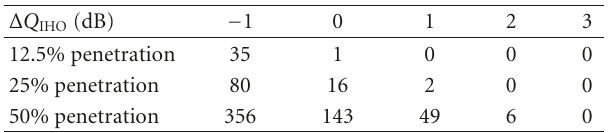
Table 5: Outages of